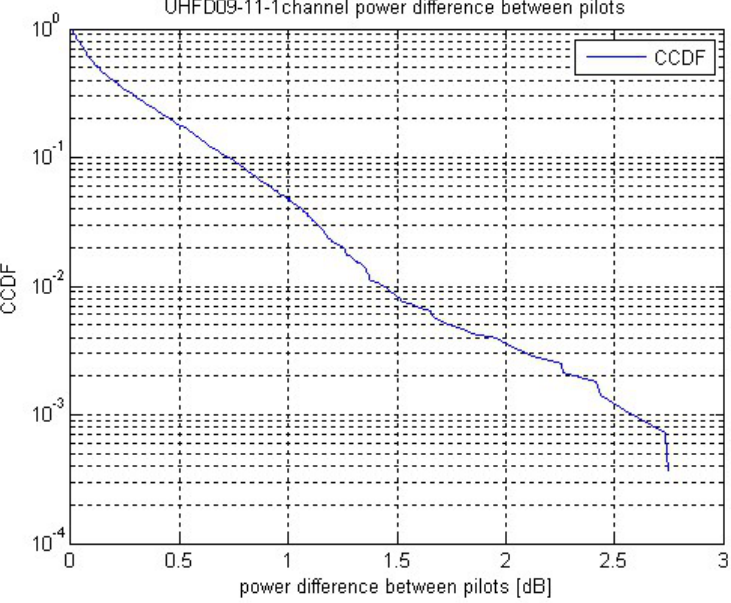
Figure 16. CCDF of inter-pilot channel power difference.